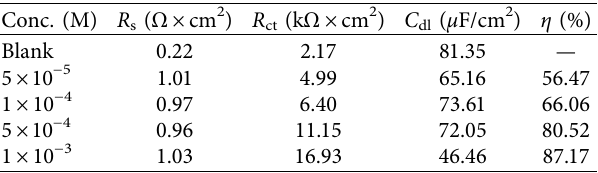
Figure 3: Nyquist plots for SS in 1M H concentrations of ACM at 293K. Table 3: EIS parameters for SS in 1M H concentrations of ACM at